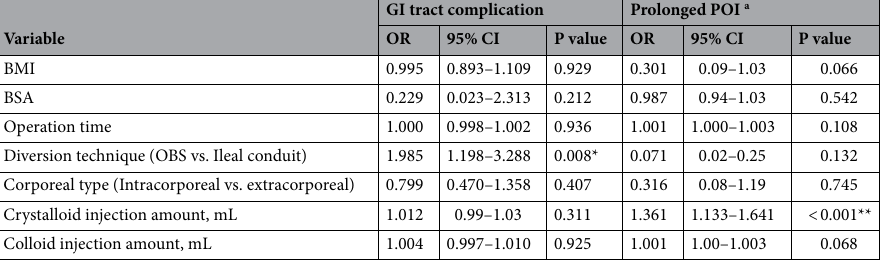
Table 4. Logistic regression analysis of variables associated with gastrointestinal complication and paralytic ileus treated with robot-assisted radical cystectomy. BMI body mass index, BSA body surface area, CI confidence interval, GI gastrointestinal, OBS orthotopic bladder substitution, OR odds ratio, RARC robot- assisted radical cystectomy. *P < 0.05, **P < 0.01. a Definition: described in the Materials and Methods